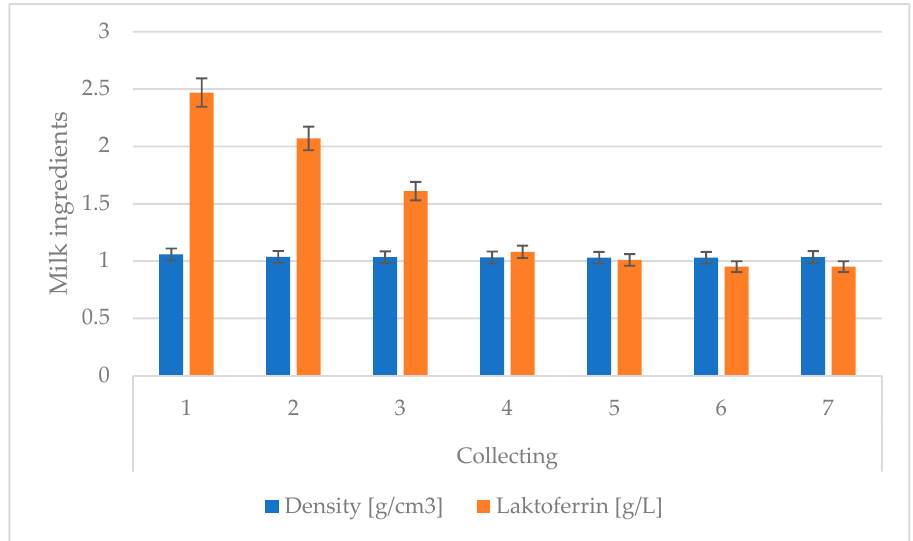
Figure 3. Changes in lactoferrin and density values for colostrum over subsequent colostrum samples. Data are presented as least squares means along with their standard errors of mean. Statistical differences between collection groups at p ≤ 0.01.